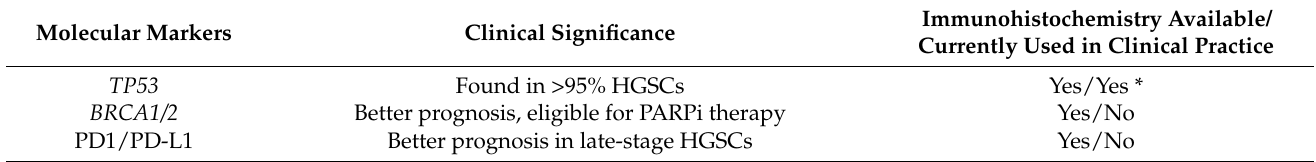
Table 1. Molecular markers of high-grade serous carcinoma.